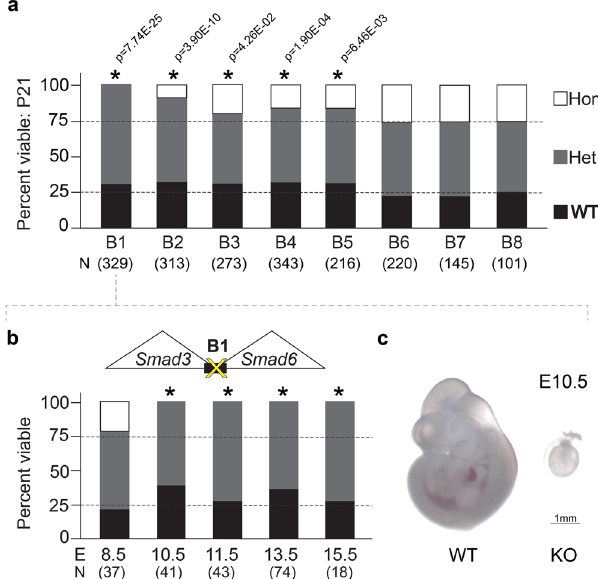
Fig. 2 TAD boundary deletions result in reduced viability. a Mendelian segregation of offspring from heterozygous crosses at weaning for all TAD boundary deletion lines. P21 postnatal day 21, N number of pups analyzed, Hom homozygous, Het heterozygous, WT wild-type. b Mendelian segregation of offspring from heterozygous crosses at designated embryonic stages for boundarydeletion locus B1 (* p <0.05). E embryonic day,N number of embryos analyzed. c Bright fi eld images of representative littermate wild- type and homozygous mutant embryos obtained at E10.5. Scale bar,